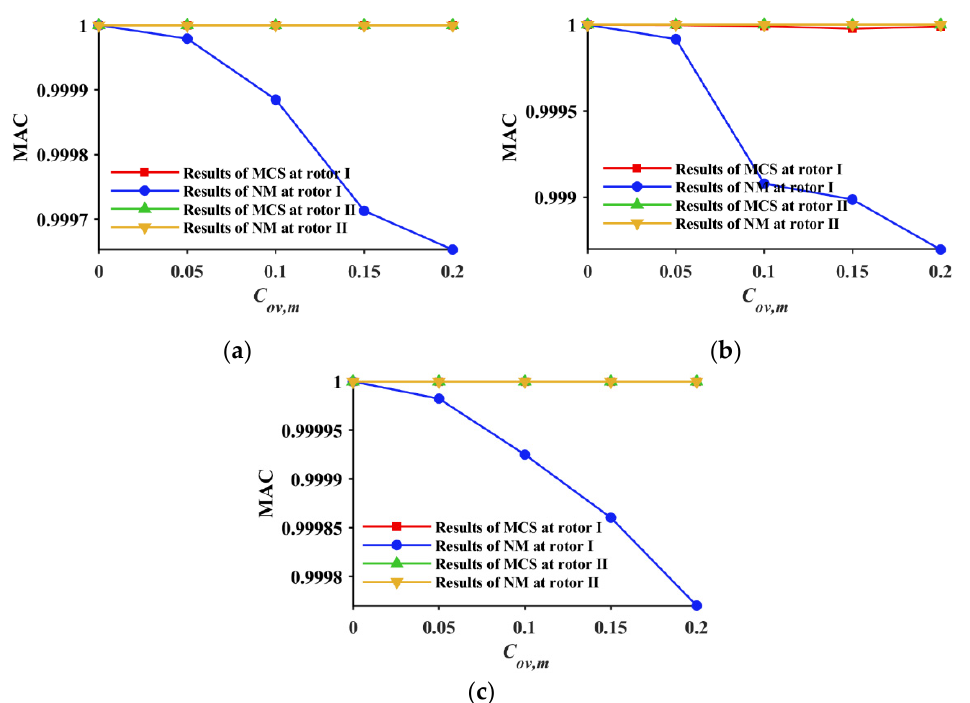
Figure 6. MAC values of the first three ‐ order vibration modes of an uncertain dual ‐ rotor system for C ov , k = 0–0.20. ( a ) MAC values of the first ‐ order vibration mode. ( b ) MAC values of the second ‐ order vibration mode. ( c ) MAC values of the third ‐ order vibration mode.